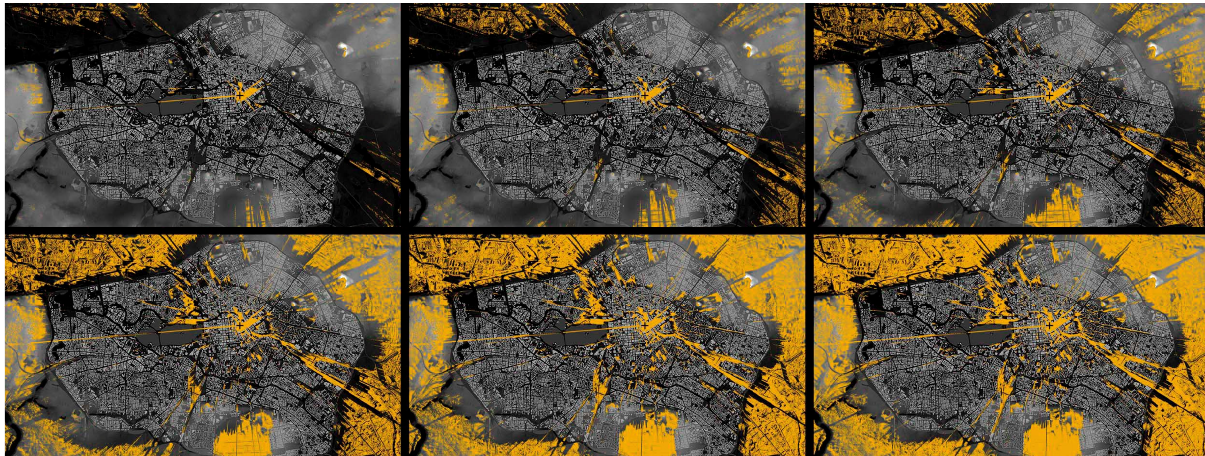
Figure 4. Visual impact of building in center of Berlin for various heights: 40, 60, 80, 100, 150, and 200 m. The sequence shows growing visual field depending on building height.